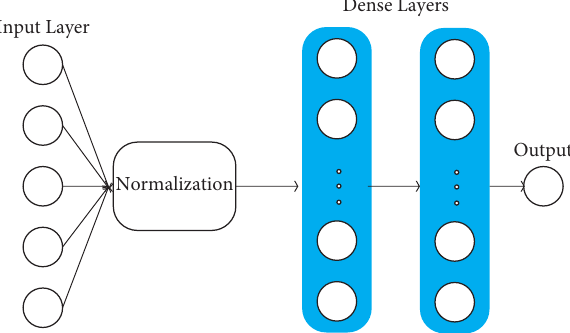
Figure 7: Model architecture extracted from the NAS method.